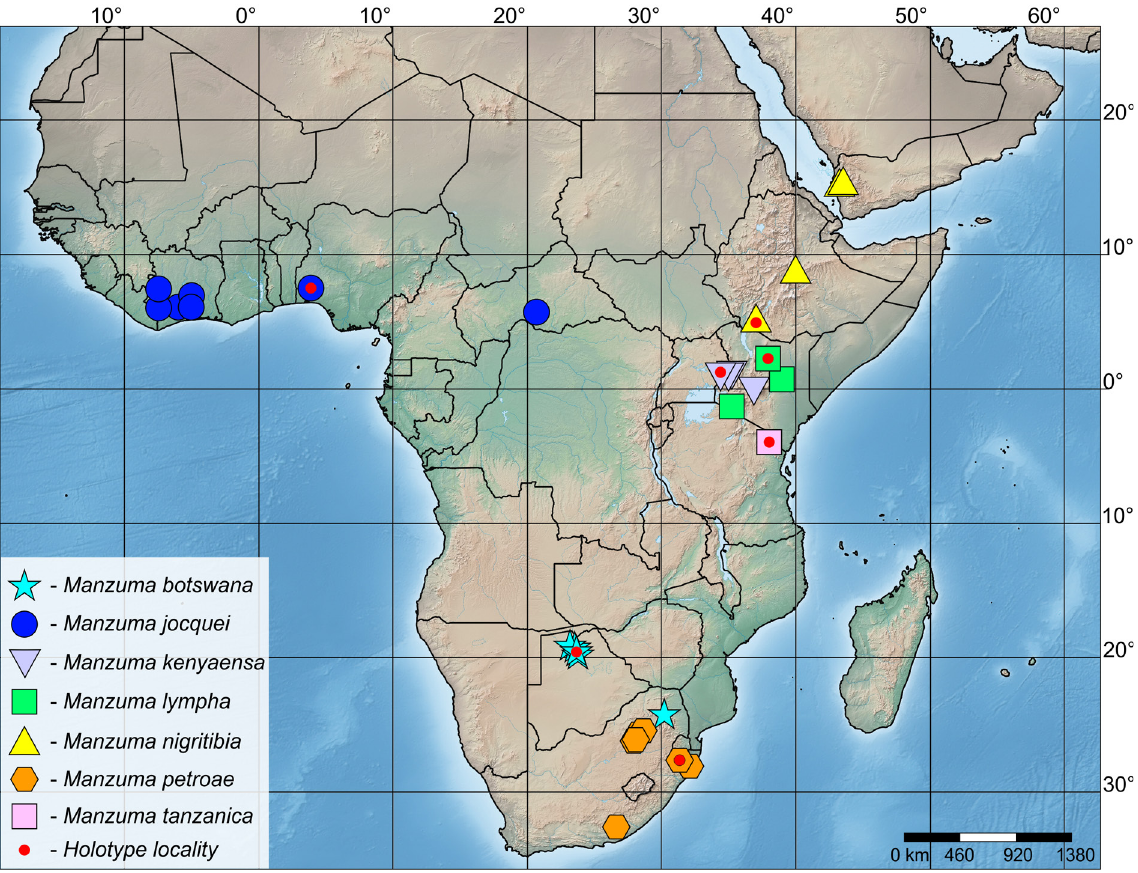
Fig. 200. Collecting localities of seven species of Manzuma gen.